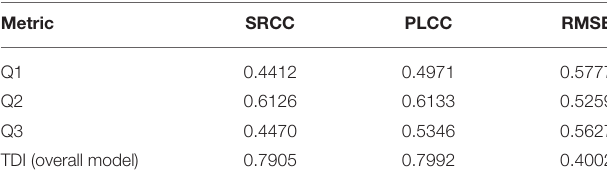
TABLE 2 | Ablation experiments about the proposed